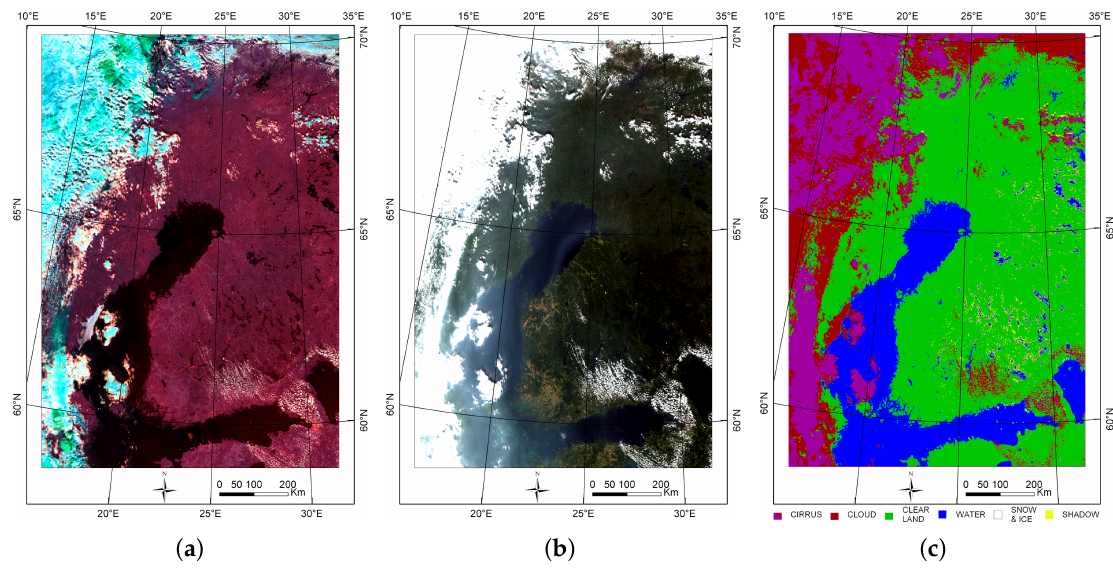
Figure 3. A Suomi NPP VIIRS image of 5 August 2014, at 09:28 a.m. ( a ) SWIR colour composite, RGB composite from 3.7 µ m, 2.2 µ m and 1.6 µ m reflectance; ( b ) Natural colours, Natural colour image from 0.672 µ m, 0.555 µ m and 0.490 µ m reflectance; ( c ) Cloud/shadow result, Cloud and shadow detection result.